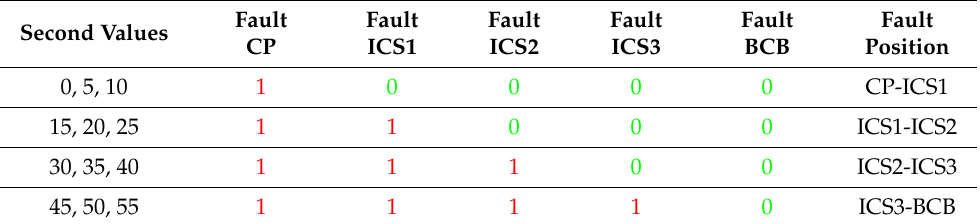
Table 8. Values of fault lines to test different fault positions. The values in red indicate the lines for which a fault signal is generated; on the contrary, green values highlights not-faulty portion of the distribution line.